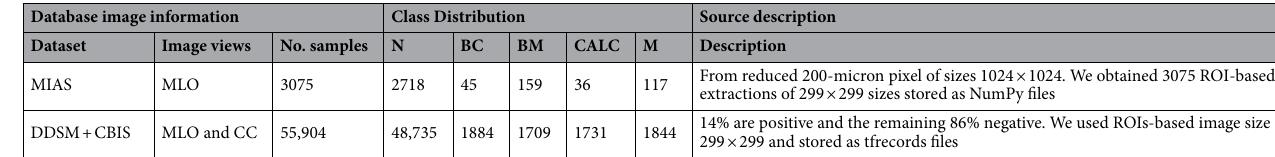
Table 3. List of mammography databases applied for experimentation. MLO mediolateral oblique view, CC craniocaudal, N normal, BC benign calcification, BM benign mass, CALC calcification, and M- mass.